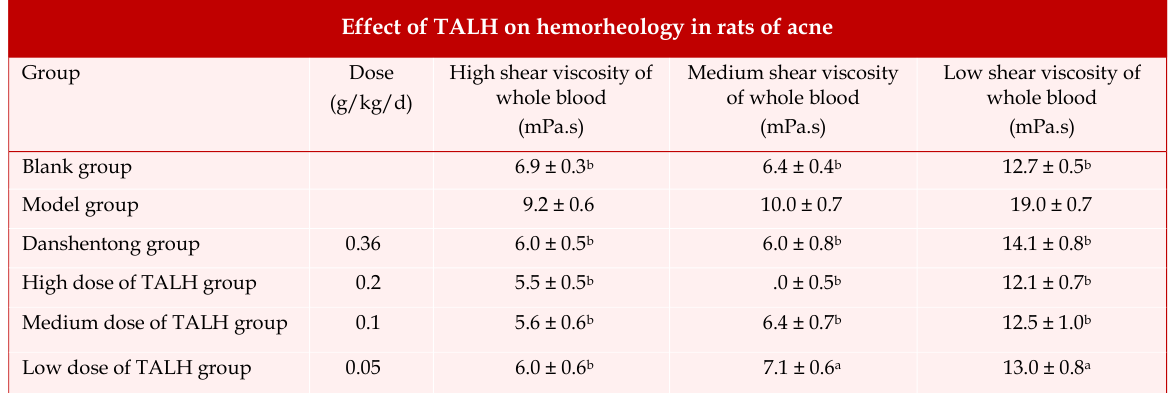
Effect of TALH on hemorheology in rats of